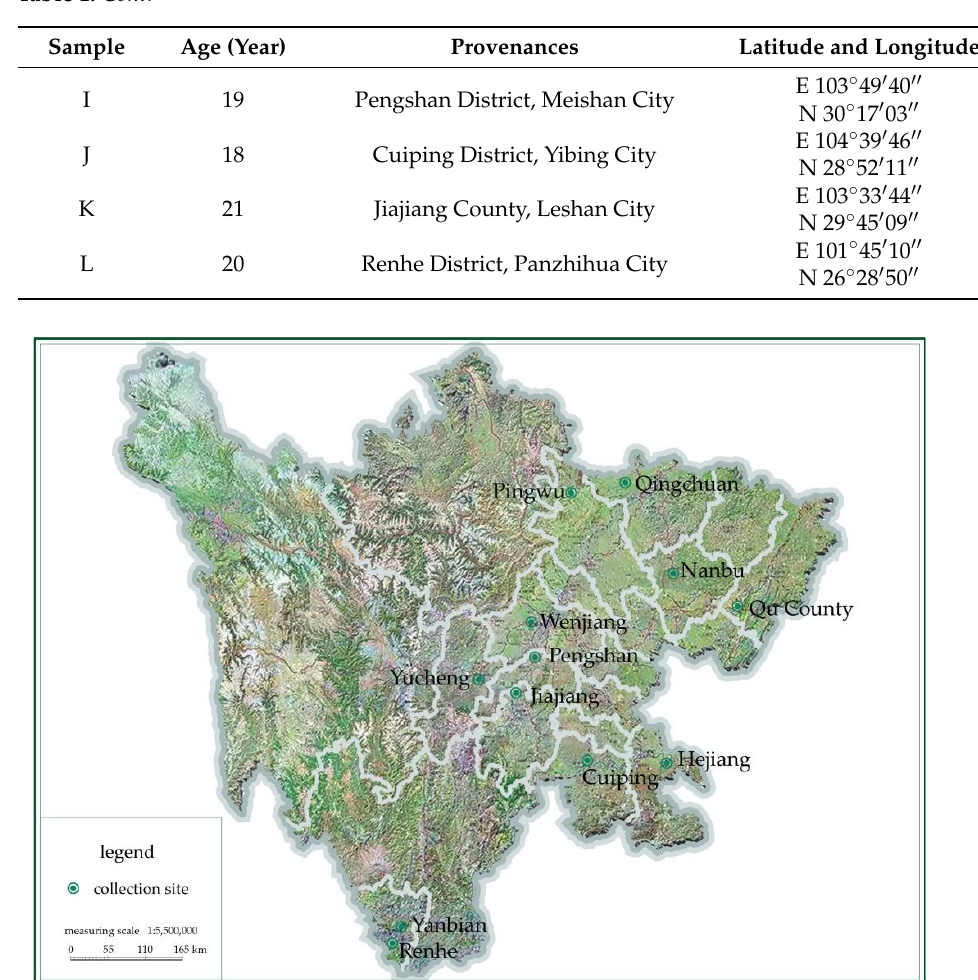
Figure 1. The map of different Alnus cremastogyne collection